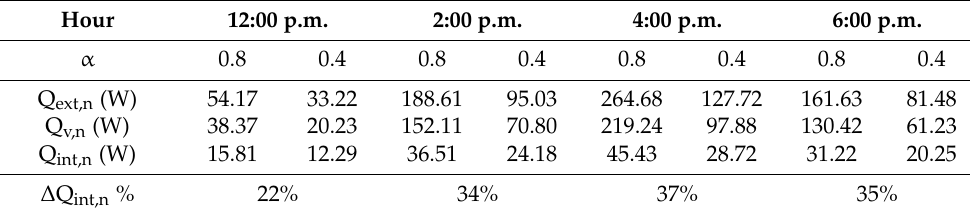
Table 3. Comparison between Q ext,n , Q v,n , and Q int,n values assuming α = 0.8 and α = 0.4 Hour